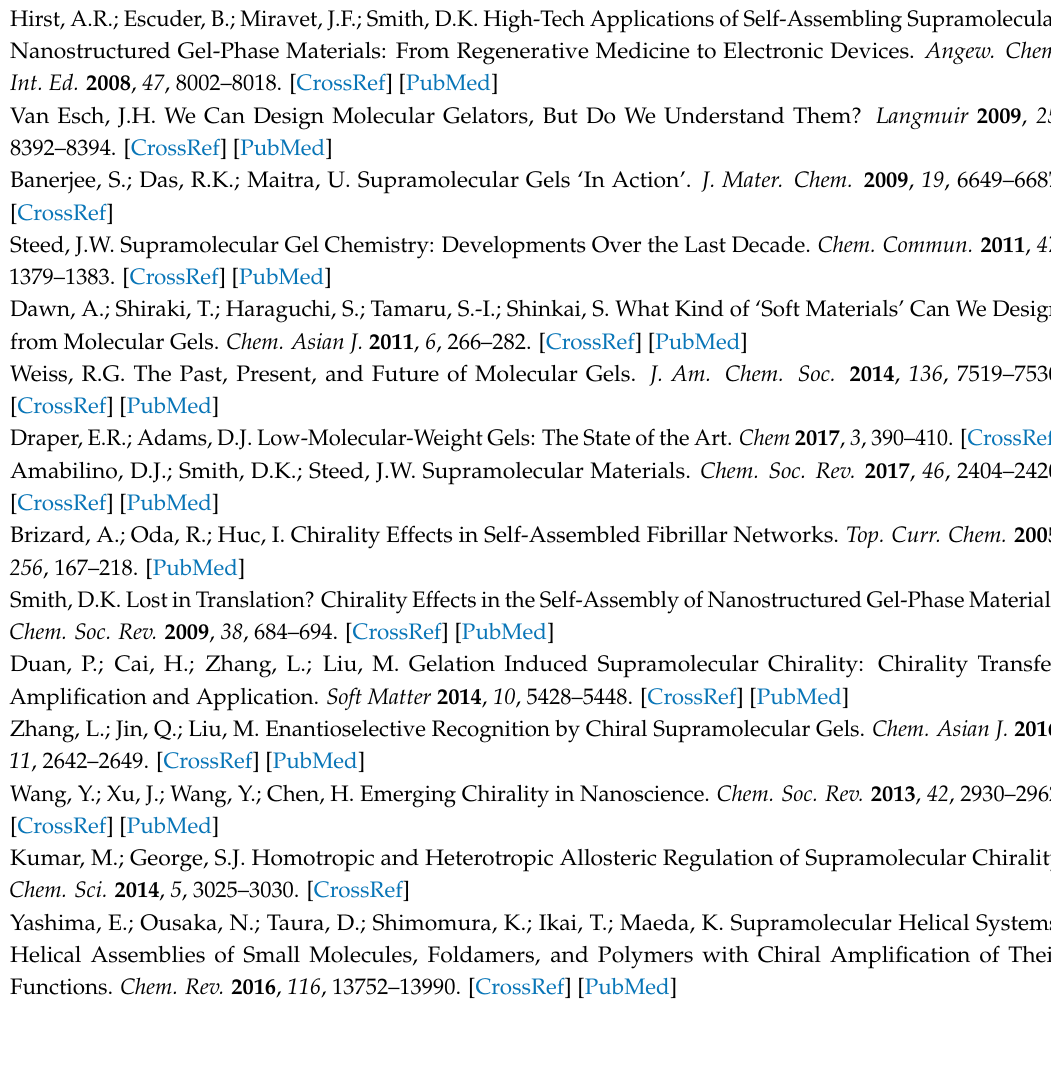
Figure S1: Effect of enantiomeric mixing on T gel , as measured by tube inversion. Concentration of amine is 10 mM, and total concentration of dendron (D,D,D + L,L,L) is also 10 mM. Figure S2: Effect of enantiomeric mixing on T gel , as measured by tube inversion. Concentration of amine is 10 mM, and total concentration of dendron (D,L,L + L,D,D) is also 10 mM. Figure S3: Effect of mixing L,L,L and D,D,D (total combined concentration 10 mM) on the T gel value in the presence of different acyclic chiral amines. Figure S4: Effect of mixing L,L,L and D,D,D (total combined concentration 10 mM) on the T gel value in the presence of different cyclic chiral amines. Figure S5: Effect of mixing L,L,L and D,D,D (total combined concentration, 10 mM) on the T gel value in the presence of different hindered chiral amines (10 mM). Figure S6: Concentration of lysine dendron visible in gels of L,L,L-G2Lys, or L , L , L -G2Lys and D , D , D -G2Lys with C8 as temperature increases (solvent: toluene- d 8 ). Van ‘t Hoff plots of gels formed from L , L , L -G2Lys or L , L , L -G2Lys and D , D , D -G2Lys with C8. Figure S7: Concentration of lysine dendron visible in gels of L , D , D -G2Lys, or L , D , D -G2Lys and D , L , L -G2Lys with C5 as temperature increases (solvent: toluene- d 8 ). Van ’t Hoff plots of gels formed from L , D , D -G2Lys or L , D , D -G2Lys and D , L , L -G2Lys with C5. Figure S8: Concentration of lysine dendron visible in gels of L , L , L -G2Lys, or D , D , D -G2Lys, or L , L , L -G2Lys and D , D , D -G2Lys with C8R as temperature increases (solvent: toluene- d 8 ). Van ’t Hoff plots of gels formed from L , L , L -G2Lys or D , D , D -G2Lys or L , L , L -G2Lys and D , D , D -G2Lys with